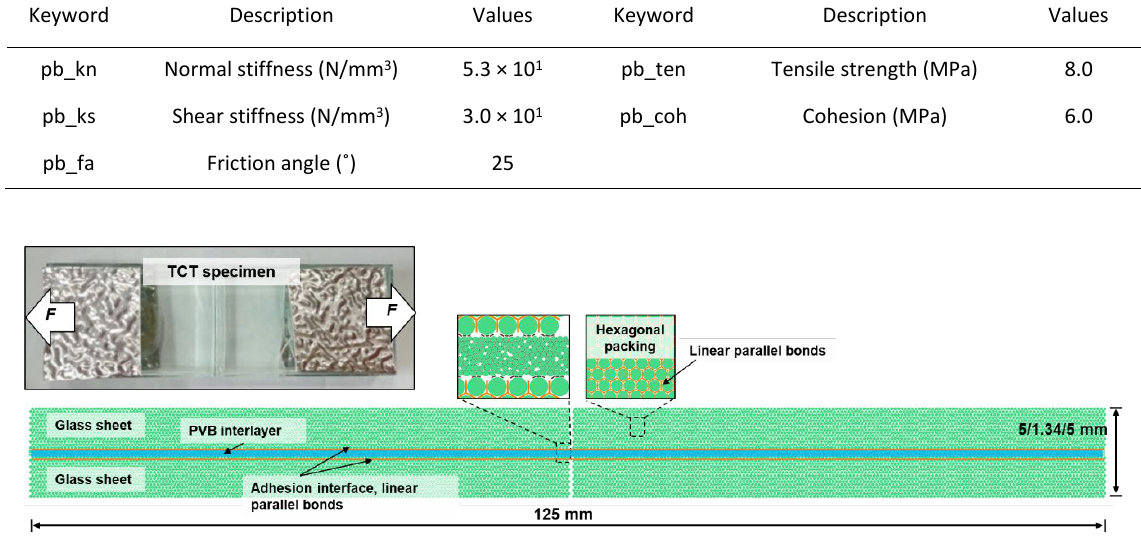
Fig. 3: Experimental TCT specimen and the configuration details of DE